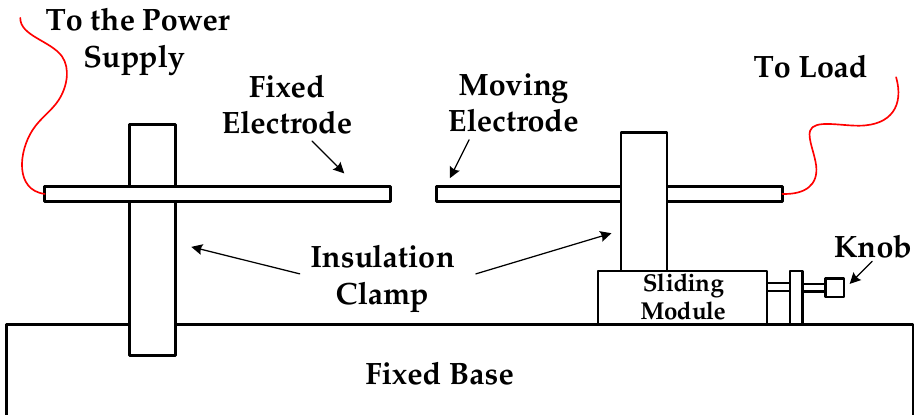
Figure 4. Structure of the arc generator.